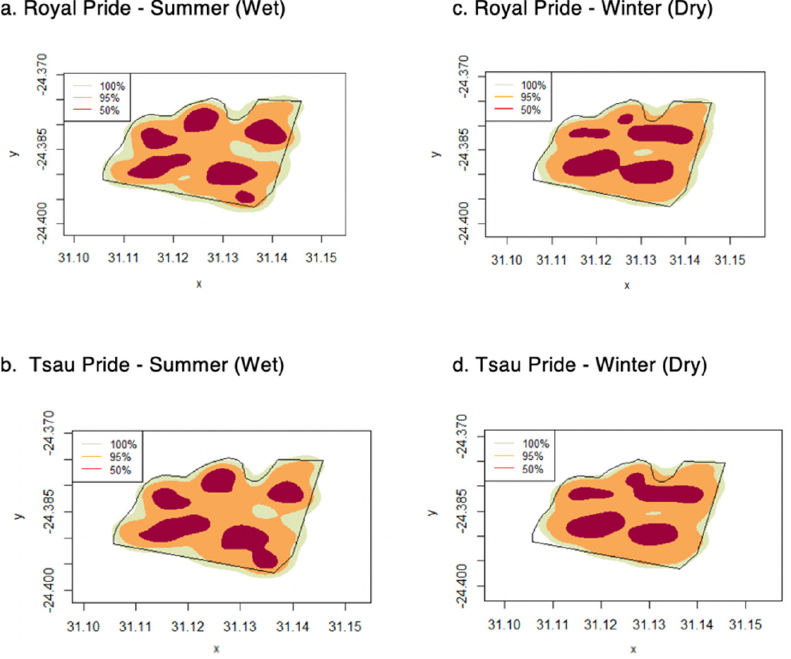
Figure 6. Seasonal home range distribution for the summer (wet) and winter (dry) seasons, for the Royal and Tsau prides, using KDE (100%, 95% and 50%) ( a – d ), at the Tula Tsau Conservation Area, Limpopo, South Africa.